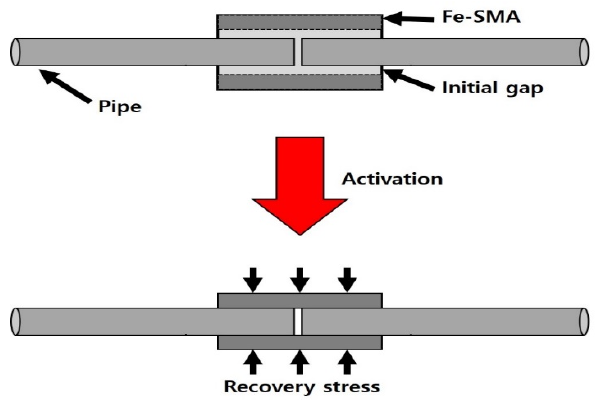
Figure 3. Schematics of pipe joining process by SMA.